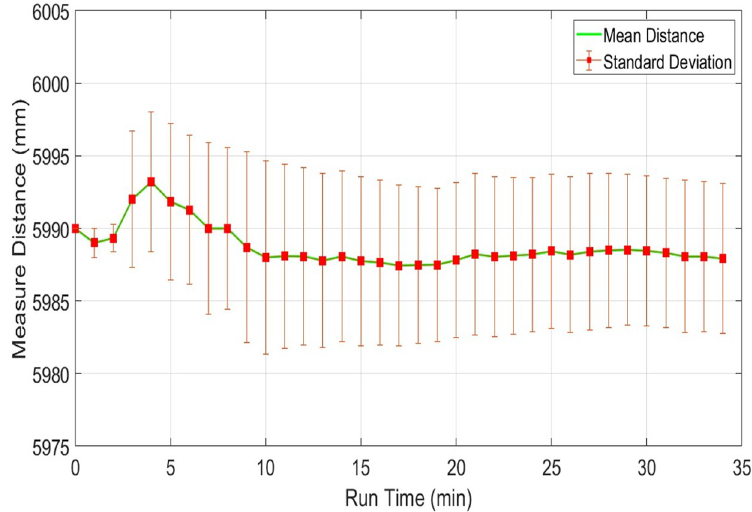
Fig 16. Range plot of Hokuyo-30LX for measuring stability test for object present at 6m